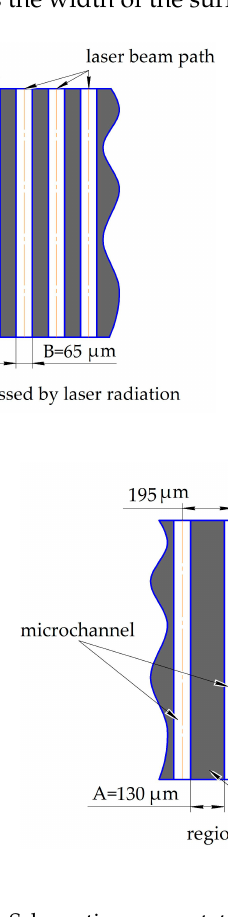
Figure 2. Schematic representations of a texture configuration in the form of parallel microchannels developed at the planning stage. ( a ) AB, ( b ) A2B, and ( c ) 2AB. A is the width of the surface area that is not subject to laser radiation and B is the width of the surface area processed by laser radiation.